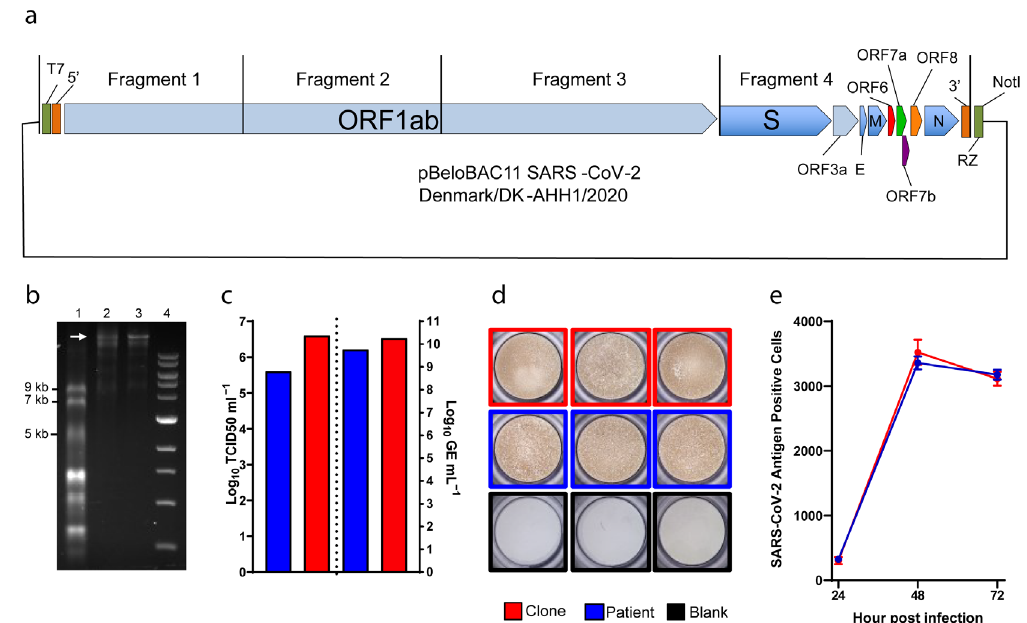
Figure 1. Reverse-genetics system for SARS-CoV-2. ( a ) Diagram of the bacterial artificial chromosome (BAC), in which the complete genome (from four cloned fragments as indicated) of SARS-CoV-2 was inserted. Individual open reading frames (ORFs) are depicted as arrow boxes. 5′ and 3′ : untranslated regions; RZ: HDV-ribozyme; NotI: restriction site. ( b ) In vitro transcription of the full-length SARS-CoV-2 plasmid, 40 ng of RNA transcript loaded per well. 1: ssRNA ladder; 2: DNase-treated RNA transcripts; 3: RNA transcripts; 4: 1kb DNA ladder. The white arrow indicates full-length RNA transcripts. ( c ) to the left of the dotted line, representative peak infectivity titers (TCID 50 /mL) of the second passage virus. To the right, RNA titers (as GE/mL) of the same samples measured by E-sequence specific RT-qPCR. ( d ) Representative pictures of infected immunostained Vero E6 cells. ( e ) Virus propagation kinetics after infection at MOI 0.01. Graphs indicate the number of infected cells determined by immunostaining ( y -axis) at different time points ( x -axis). Data are shown as mean and standard error of the mean. Patient (blue): virus isolated from a COVID-19 patient [22]; clone (red): virus rescued from RNA transcribed from the clone illustrated in ( a ); blank (black): culture medium.